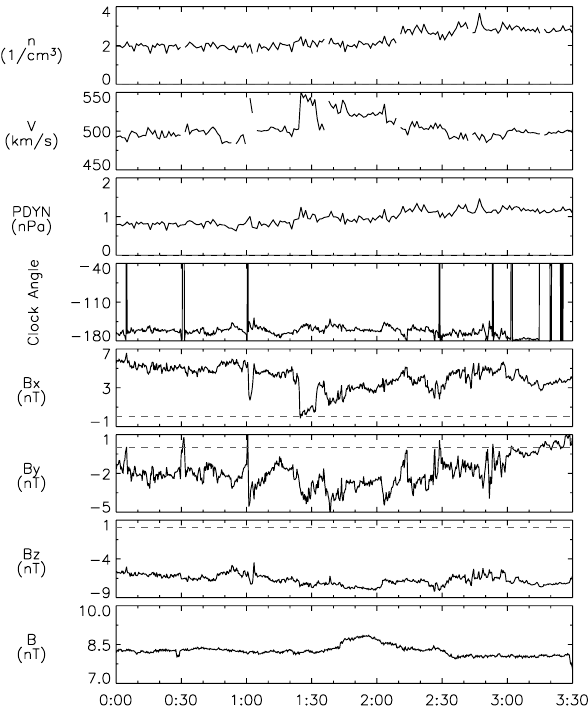
Fig. 2. The solar wind and IMF measurements in GSM from the ACE spacecraft. The time is shifted by 54.4min to match the sud- den northward turning of the IMF measured at both the ACE and the four Cluster spacecraft. Notice the IMF B z was negative throughout the whole interval. The IMF B y was also